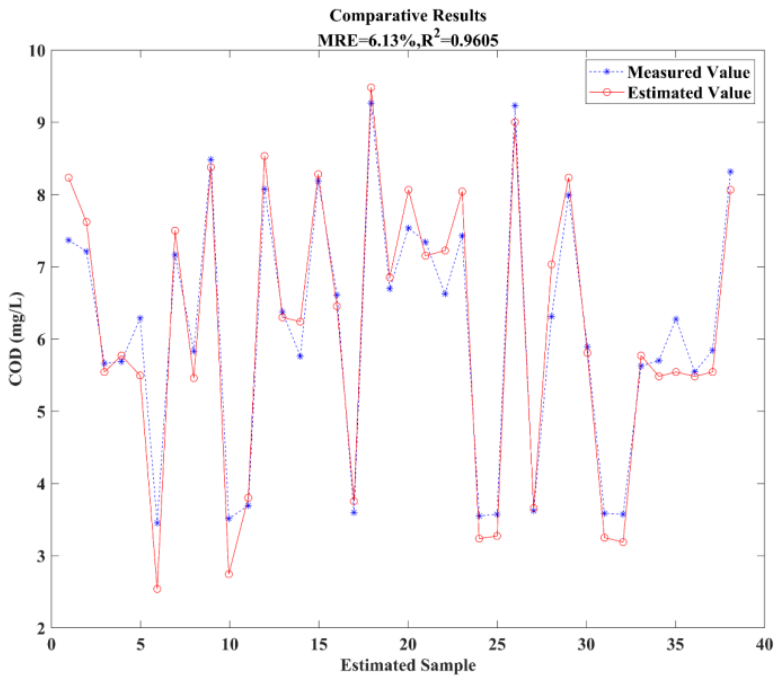
Figure 12. Comparative results of the water quality parameter model based on combined prediction.